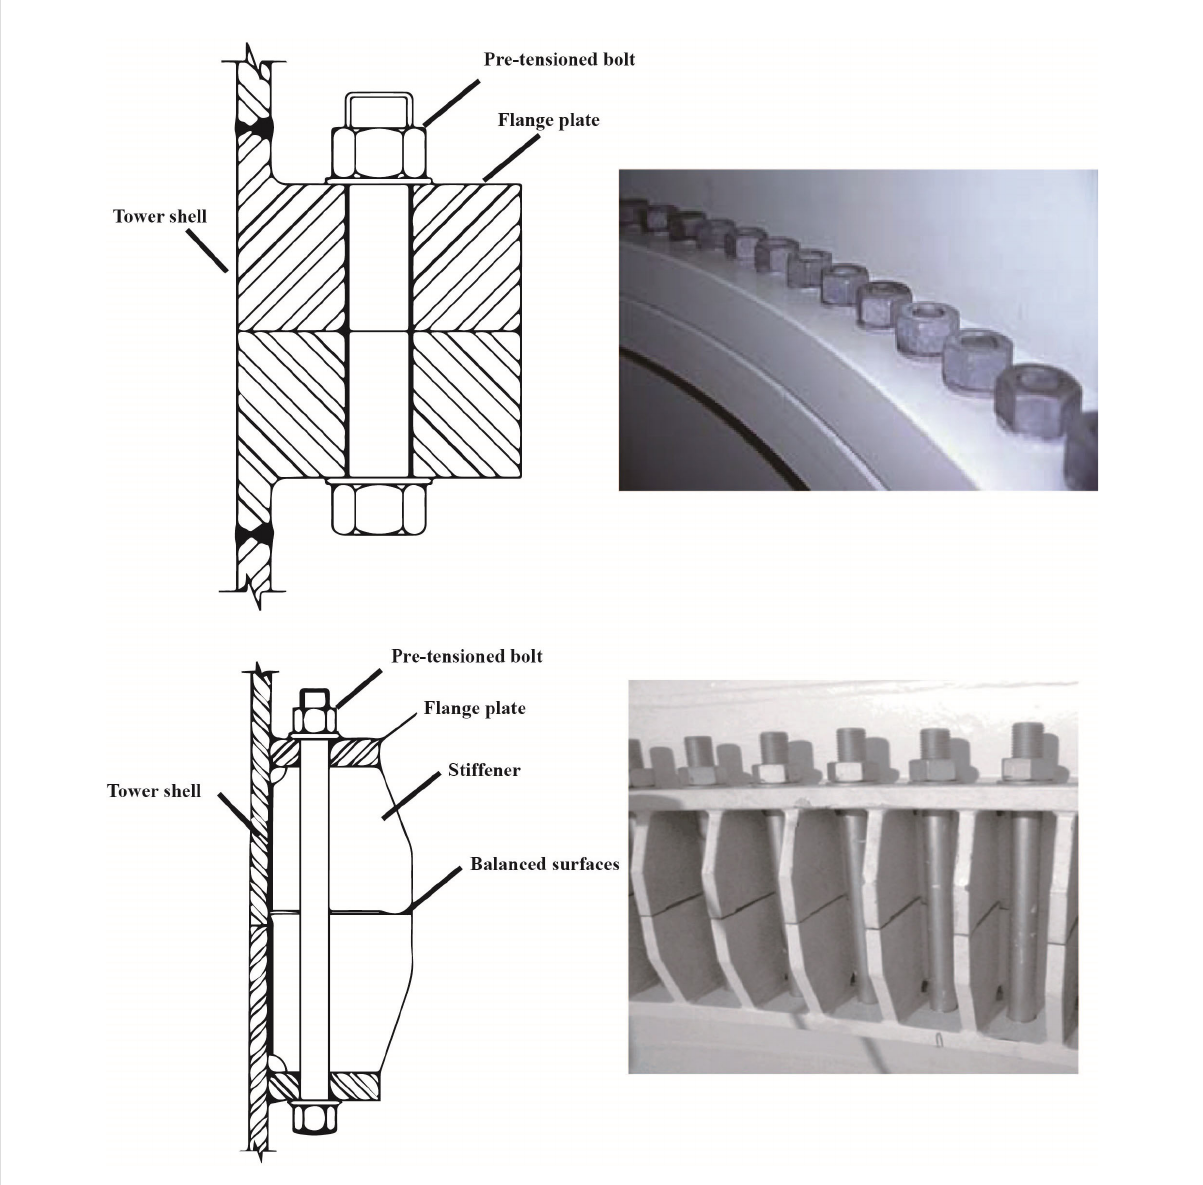
FIGURE 3 Con fi gurations of L-shape fl anges (up) and reverse balanced fl anges (down) (He et al., 2016; Alonso-Martinez et al., 2019) description of environmental